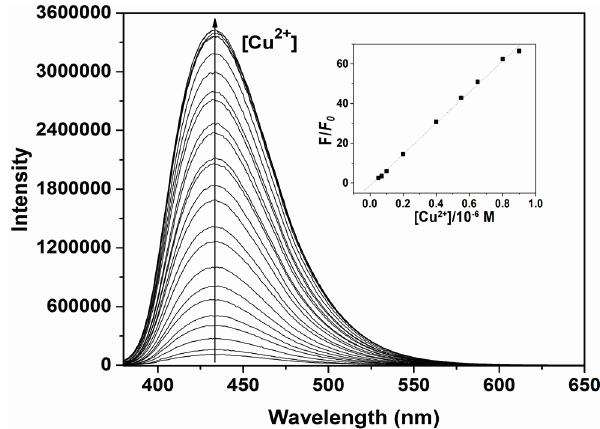
Figure 4. Fluorescence spectra of P (2 μ M) in ethanol-water solution (3:2, v:v, 50 mM HEPES, pH 7.4) in the presence of different amounts of Cu 2+ . Inset: Fluorescence intensity at 432 nm as a function of Cu 2+